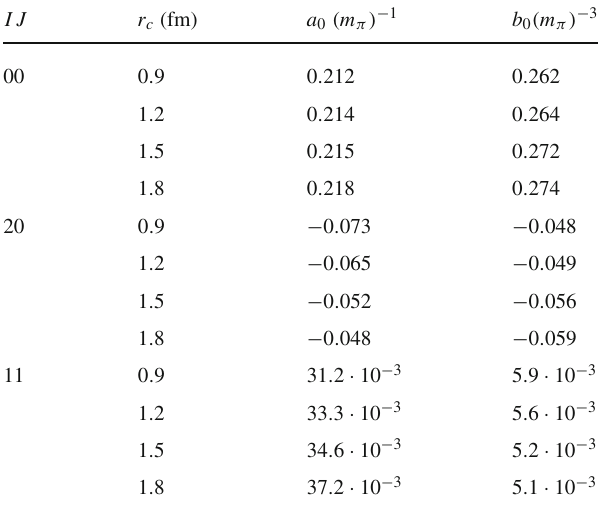
Table 2 Scattering lengths and slope parameters for the different fits without TPE with an increasing number of delta shells separated by (cid:14) r = 0 . 3